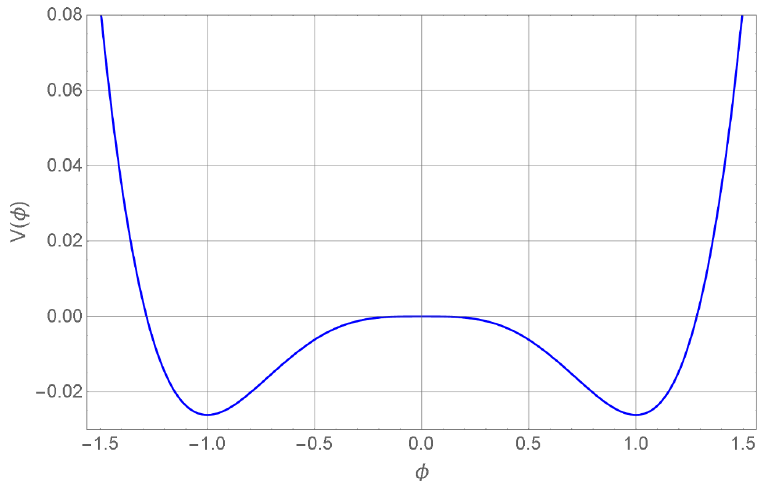
Figure 3 . CW Potential in eq. (3.19) as a function of the scalar field for ξ = f 0 = f 2 = h φ i = 1